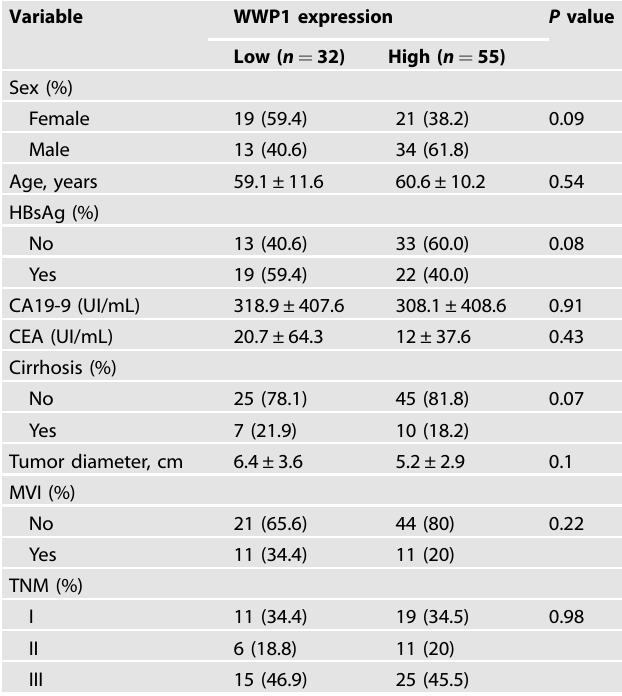
Table 1. Correlation between WWP1 and clinicopathological characteristics in ICC